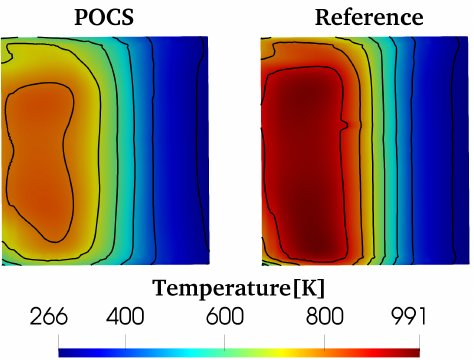
Figure 19. Cold start assessment: CAT1 temperature fields comparison—simulation end-time.